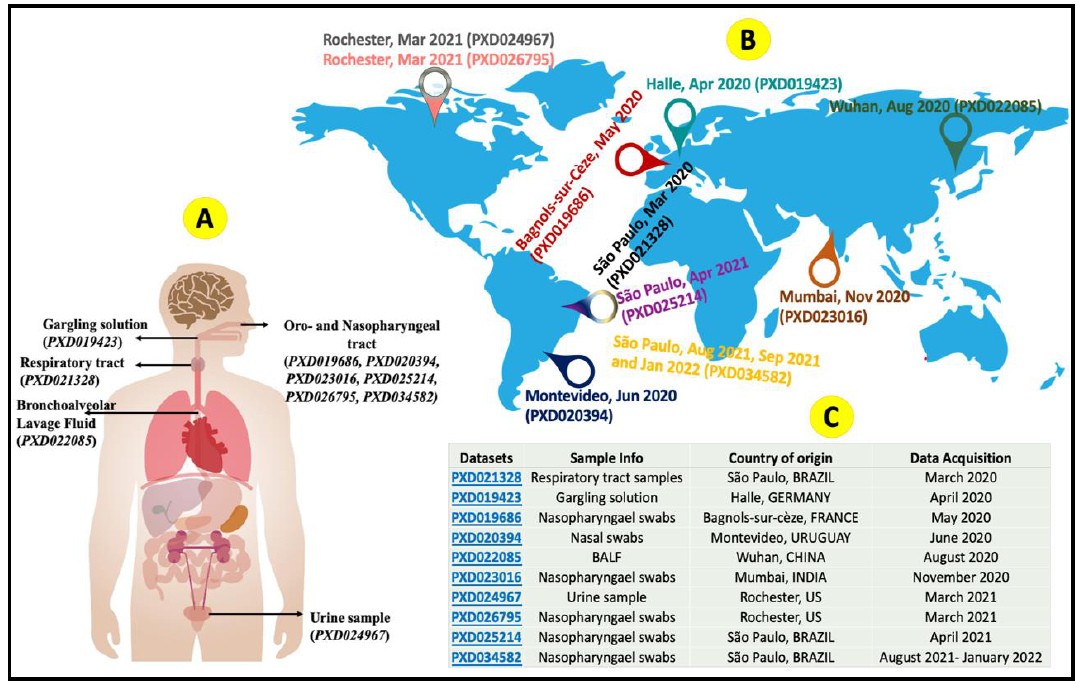
Figure 1. Publicly available clinical tandem mass spectrometry (MS/MS) datasets from ProteomeXchange were used for the variant detection study. ( A ) Samples came from different parts of the human body. ( B ) Samples and generated datasets were obtained at different timepoints and locations, following the geographical and temporal dynamics of the infection waves. ( C ) Table summa- rizing the ProteomeXchange accession numbers and geographical and temporal information asso- ciated with each dataset.